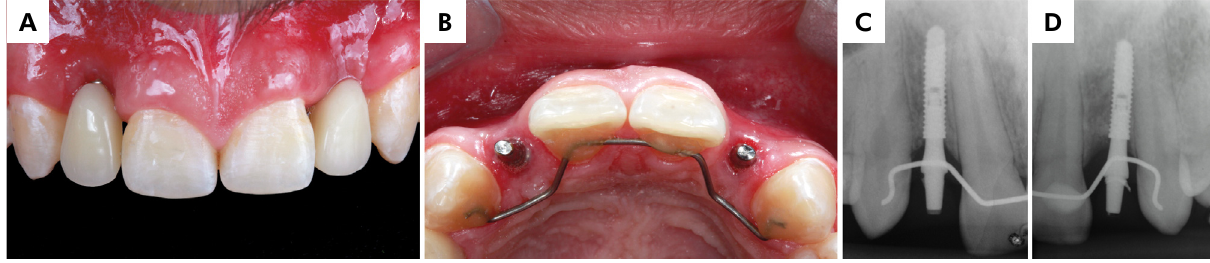
Figure 3. Patient presented loss of facial volume and papillae, color alteration and peri-implant recession (a,b) at both implants sites (#12 and #22). Even though the implants presented stable peri-implant bone at the interproximal aspect (c,d), there were esthetic and functional